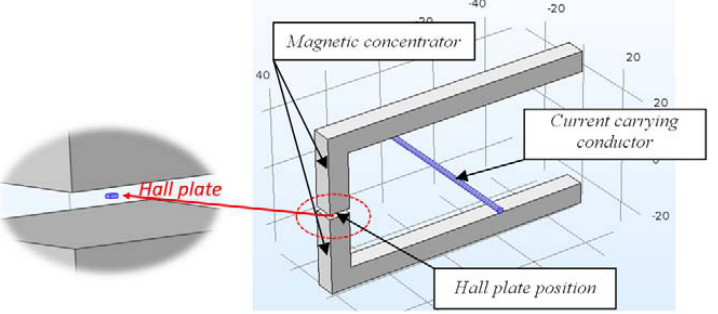
Figure 1. Construction with one air gap.